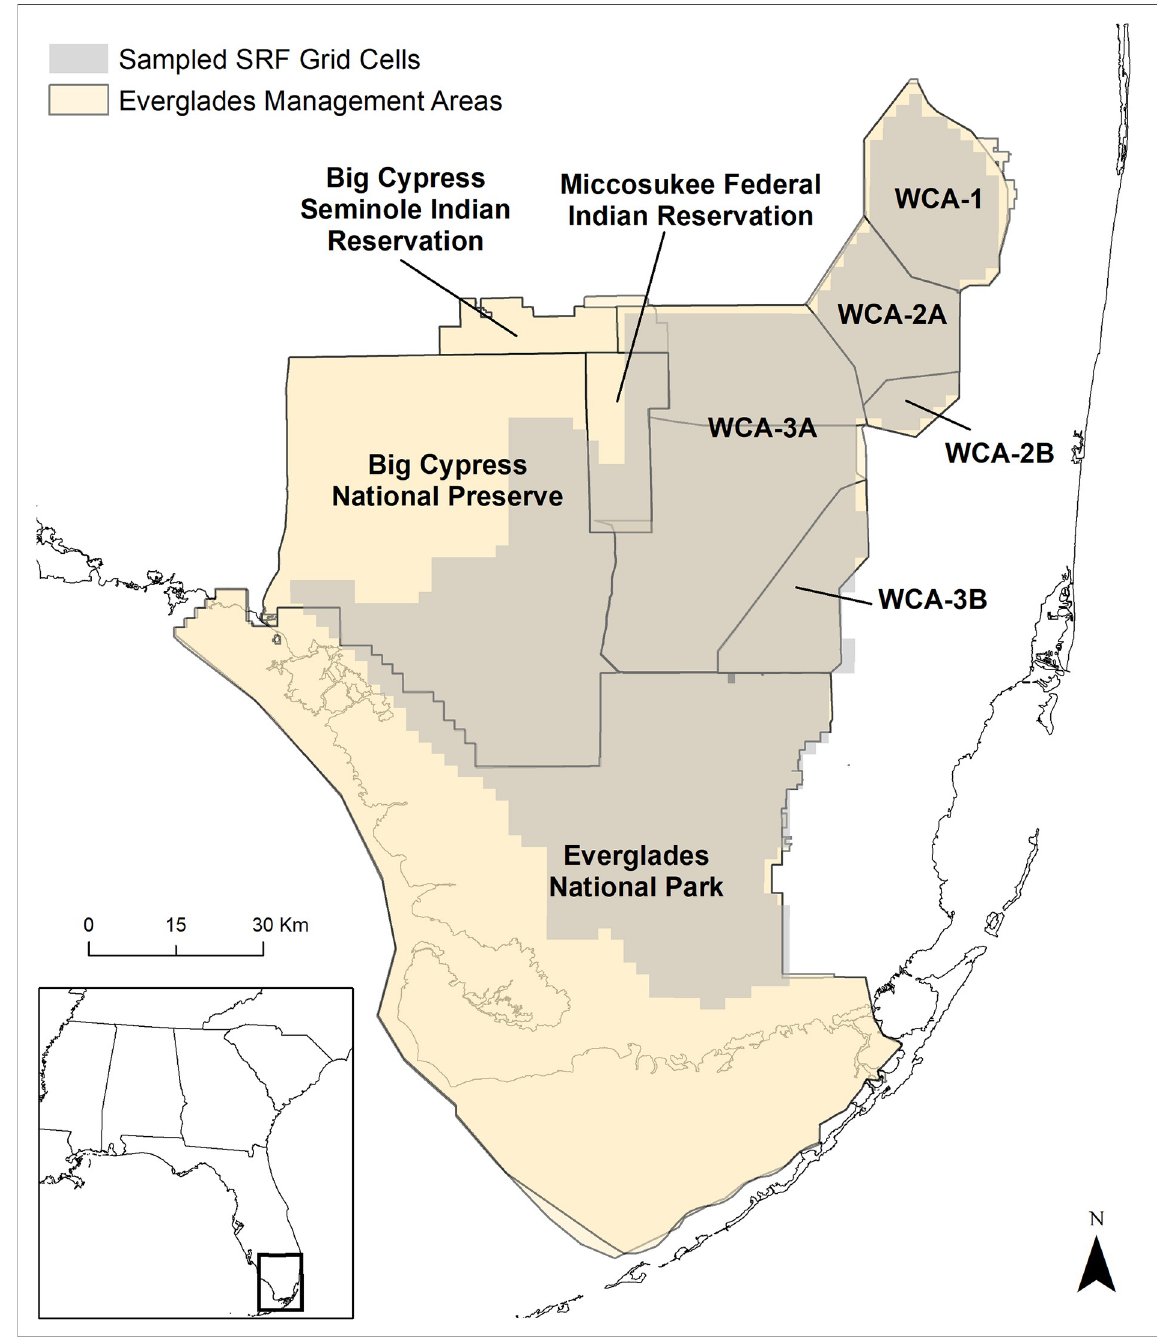
Fig 1. Sampling locations. Spatial extent of the Systematic Reconnaissance Flight (SRF) grid cells used to fit a joint species distribution model for wading birds and their location relative to protected areas within the southern Everglades. These areas include the Big Cypress Seminole Indian Reservation, the Miccosukee Federal Indian Reservation, Water Conservation Areas (WCA-1, 2A, 2B, 3A, and 3B), Big Cypress National Preserve (BCNP), and Everglades National Park (ENP). The grid shown is only those cells used in the model; the full extent of the SRF surveys is larger. Sources: Shapefiles for U.S. state boundaries available from census.gov. Shapefiles for the Everglades Management Areas provided by the Florida Fish and Wildlife Conservation Commission (https://gis.myfwc.com/Data/KMZ_files/Management%20-%20Wildlife%20Mgt%20Areas %20-%20Generalized%20-%20FL.kmz), the U.S. Fish and Wildlife Service (https://ecos.fws.gov/ServCat/Reference/Profile/128178) and the National Park Service (https://public-nps.opendata.arcgis.com/datasets/nps-boundary-1). Indian Reservation shapefiles provided by the U.S. Bureau of Indian Affairs (https://www.sciencebase.gov/catalog/item/4f4e4a2ee4b07f02db61576c).